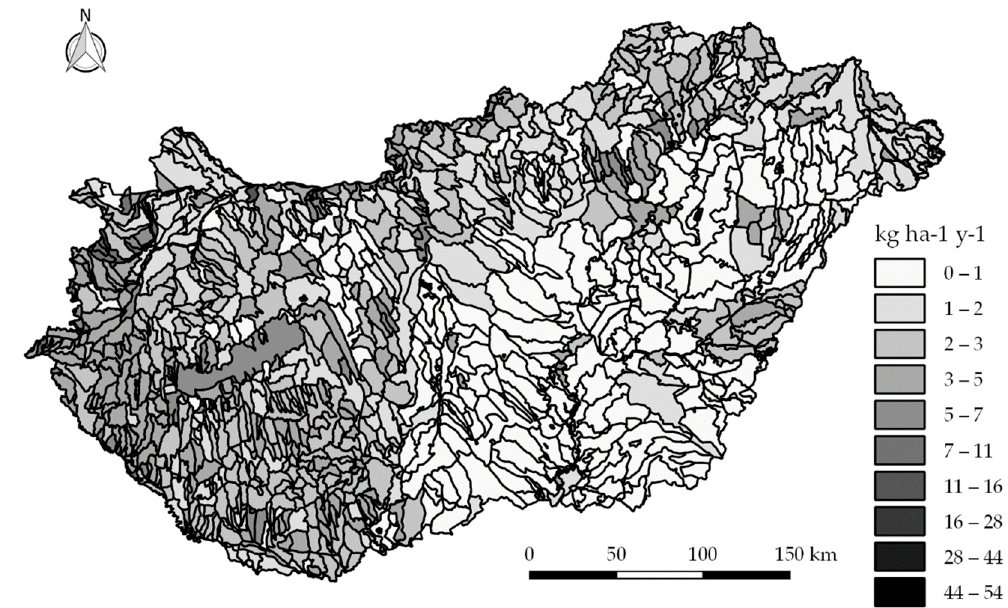
Figure 10. Di ff use-source area-specific TN emissions (totals of all Figure 10. Diffuse-source area-specific TN emissions (totals of all pathways).